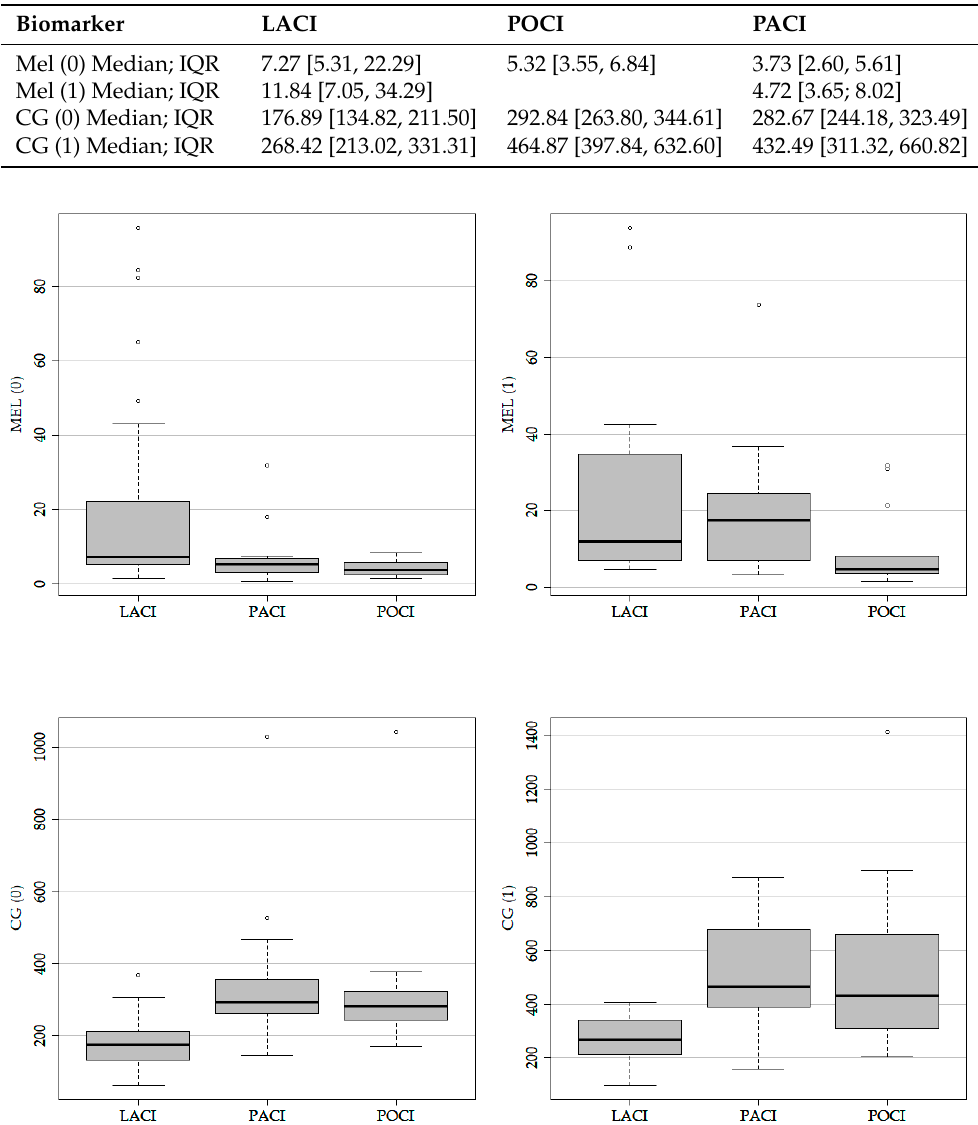
Table 5. Differences in biomarker concentrations versus stroke types.